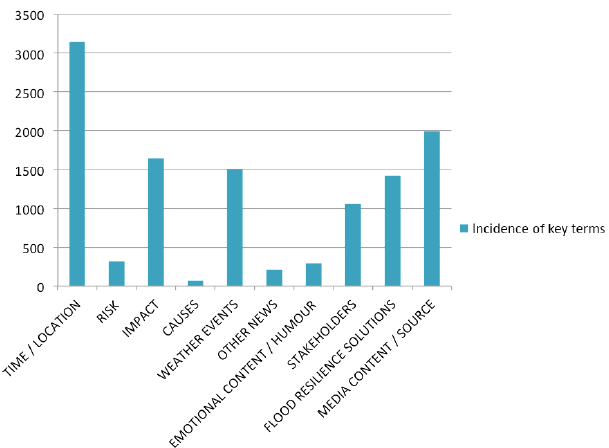
Figure 4. Twitter coverage of the 2016 Seine River flood: key term incidence aggregated in 10 thematic categories. The key terms were extracted from the corpus of tweets.